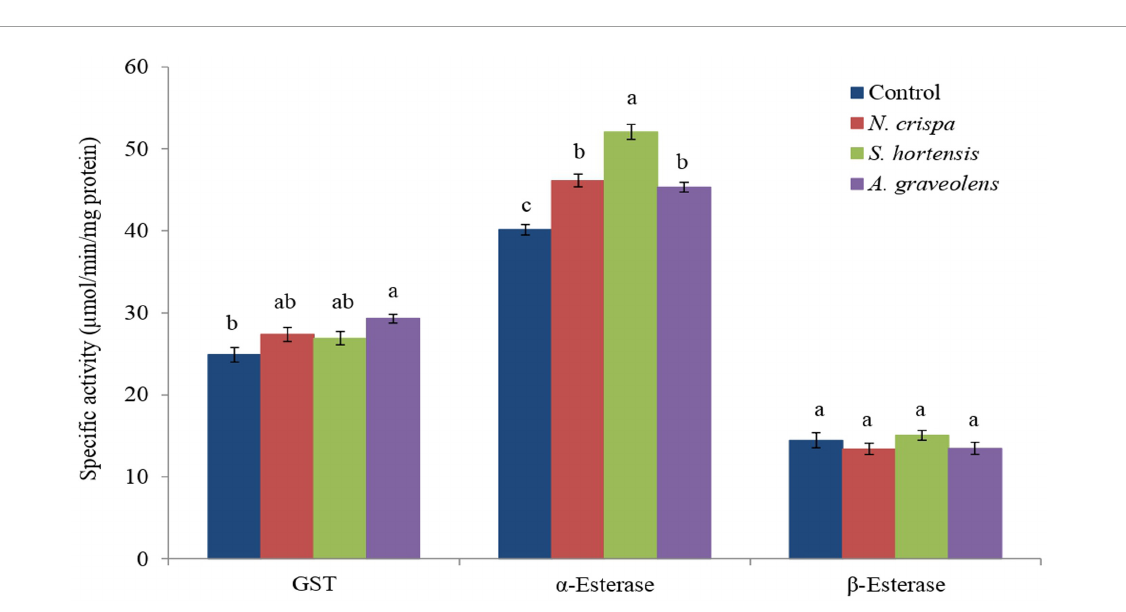
FIGURE3 The enzyme activity (mean ± SE) of A. swirskii ( µ mol min − 1 mg protein − 1 ) females exposed to N. crispa , S. hortensis , and A. graveolens oils. Different letters indicate significant differences between treatments based on Tukey’s test ( P <